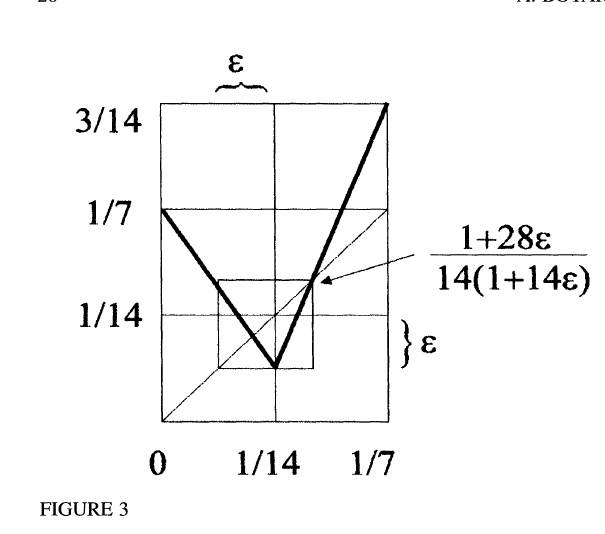
becomes an absorbing graph: if node s is removed, then node s 1 becomes a global